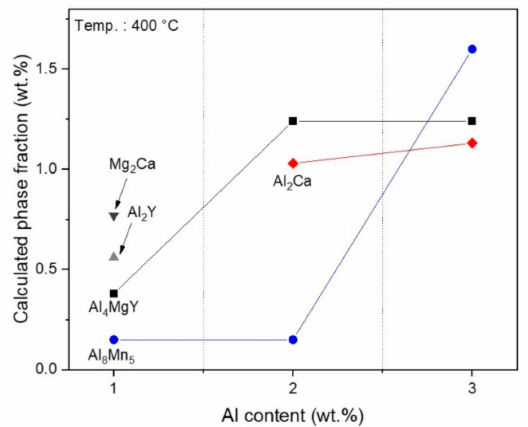
Figure 4. Calculated phase fraction of the investigated alloys at 400 ◦ C as a function of Al content.